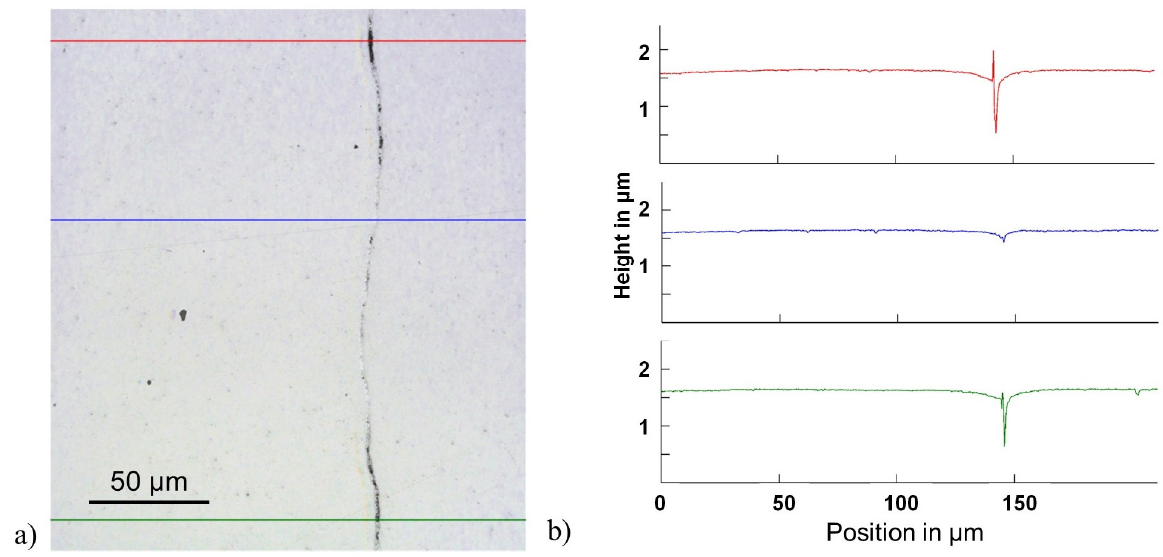
Figure 1. Optical analysis of the bond continuity ( a ) and selective height measurements ( b ).